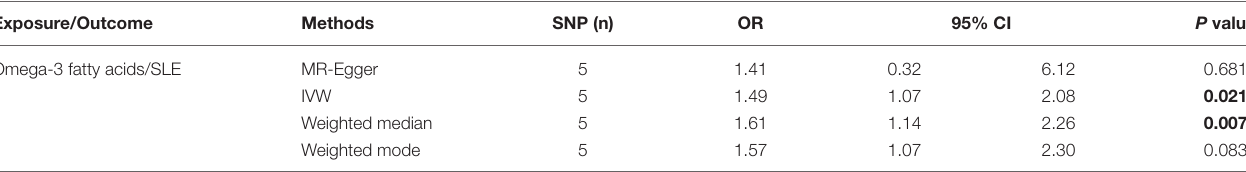
TABLE 1 | Causal effects of Omega-3 on the risk for systemic lupus erythematosus (SLE).